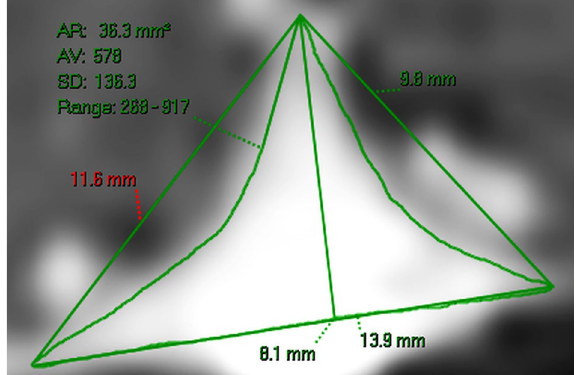
Figure 2. Measurements in a control patient. A reconstruction of the 3DT1 post contrast data from a control patient. The baseline length is 13.9 mm and the perpendicular height is 8.1 mm giving a triangle area of 56.3 mm 2 . The deflection area on each side averages 10 mm 2 (56.3–36.3/2). The average chord length between the vertex and both base attachments is 10.7 mm using Pythagoras’ theorem. Giving an average deflection distance using Eq. (4) of 1.4 mm which is equivalent to the actual deflection in this case. Note, any sinus area below the baseline is ignored in this modelling